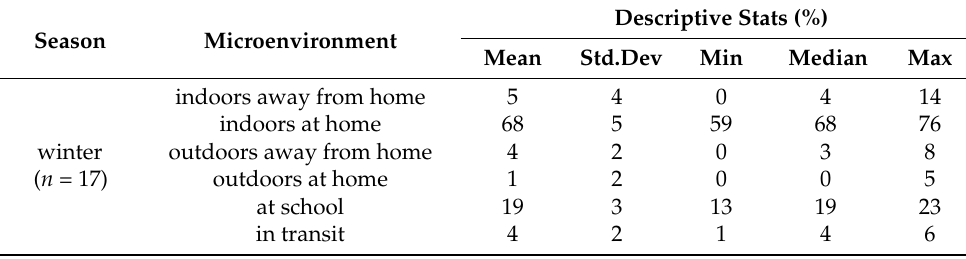
Table 2. Personal per cent of time spent in different microenvironments, by